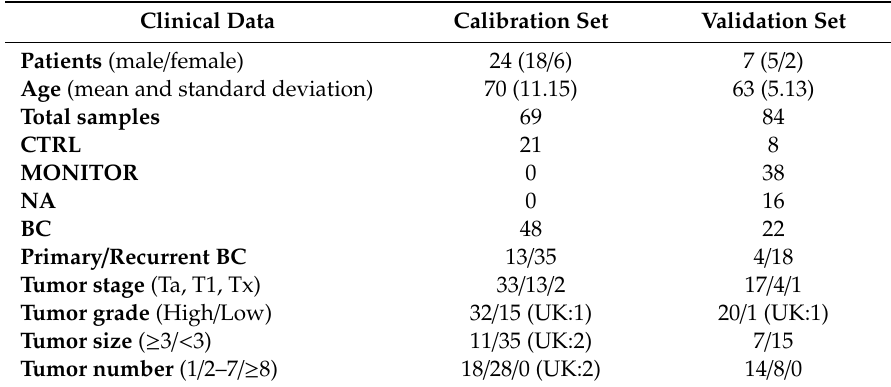
Table 4. Clinical and demographic data of patients included in this